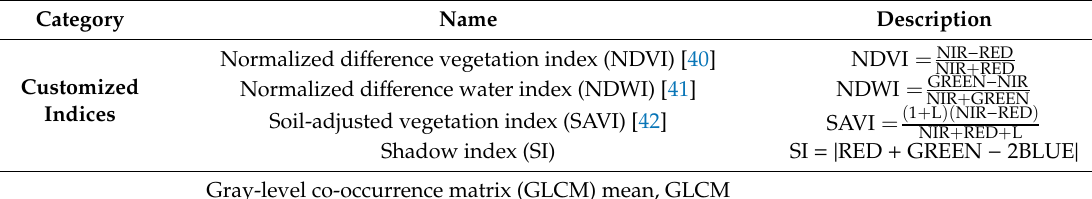
Table 1. Physicalcharacteristicsofthehigh-spatial-resolutionremotesensingimage.